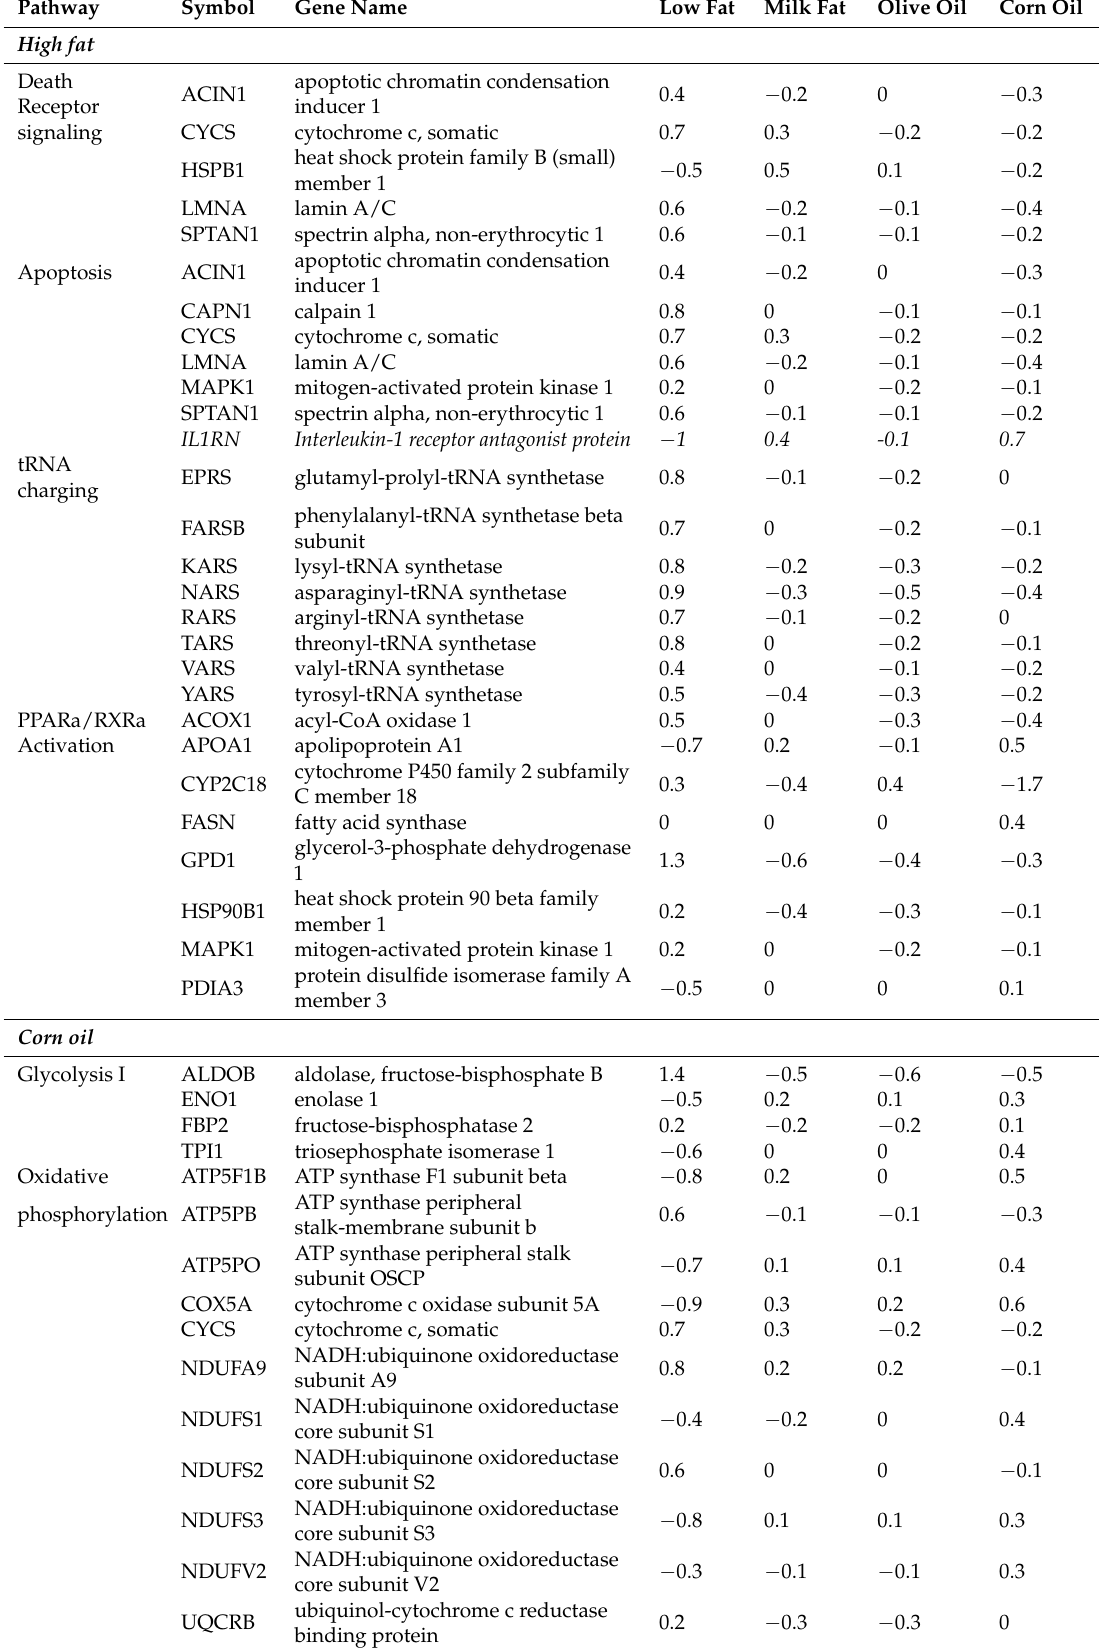
Table 1. Mucosal proteins contributing to IPA pathways and